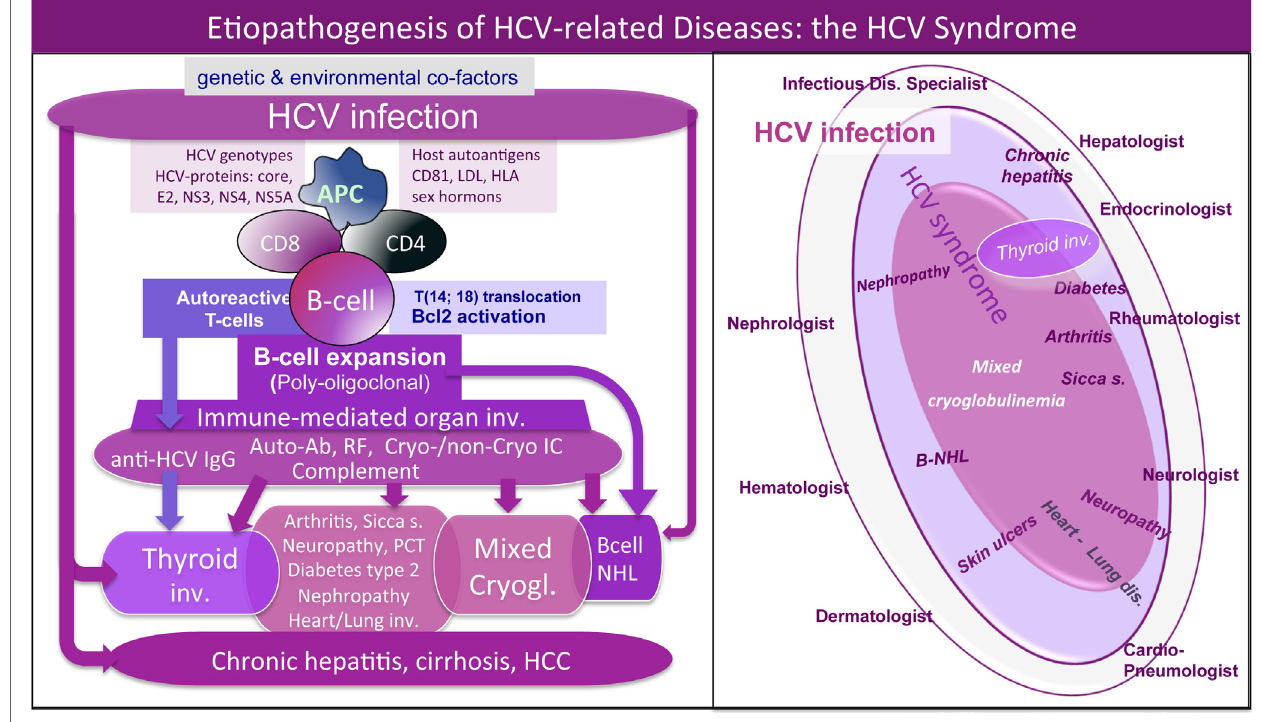
FigURe 1 | Etiopathogenesis of hepatitis C virus (HCV)-related disorders and HCV syndrome. Left : the etiopathogenesis of HCV syndrome includes both hepatic and extrahepatic disorders. They may develop through a multifactorial and multistep process that includes chronic HCV infection, other potential environmental/toxic triggers, genetically driven host predisposition (particularly HLA alleles, metabolic, and/or hormonal factors), and complex cellular and molecular alterations. From one side, we can observe HCV-driven immune-system alterations with prominent “benign” lymphoproliferation and autoantibody production, from the other side, deeper oncogenetic alterations leading to frank B-cell neoplasias and other malignancies (B-NHL, HCC, and papillary thyroid cancer). These different pathogenetic mechanisms are not mutually exclusive; during long-term follow-up, we can assist in the same HCV-infected patient to the appearance of different organ- and non-organ-specific autoimmune/neoplastic diseases, among which thyroid involvement. HCV antigens (core, envelope E2, NS3, NS4, NS5A proteins) may exert a chronic stimulus on the host immune system. Important pathogenetic steps include high-affinity binding between HCV-E2 and CD81 and consequent t (14;18) translocation with bcl-2 proto-oncogene activation, cross-reaction between particular HCV antigens and host autoantigens (molecular mimicry mechanism), and direct cell infection by HCV responsible for neoplastic cell transformation. The “benign,” often subclinical, B-cell proliferation with production of various autoantibodies, among which RF and cryo- and non-cryoprecipitable immune complexes may be frequently observed in chronically HCV-infected individuals. This condition may be the pathological substrate of various organ- and non-organ-specific autoimmune disorders, including thyroid involvement with/without mixed cryoglobulinemia (MC) syndrome or cryoglobulinemic vasculitis. Complicating malignancies can be observed in a small but significant percentage of patients, usually as a late complication of chronic HCV infection; moreover, both autoimmune and neoplastic disorders show a clinico-serological and pathological overlap. Right : schematic reproduction of the so-called “HCV syndrome” that encompasses the variety of HCV-related diseases. The majority of HCV-infected patients may remain totally asymptomatic or complicated by isolated liver involvement; however, a significant proportion of subjects may develop various extrahepatic manifestations that may include a variety of autoimmune/lymphoproliferative and neoplastic disorders; therefore HCV-positive patients are commonly referred to different specialists according the prevalent clinical manifestation(s). A number of HCV- infected patients may be referred early to the rheumatologist because of mild clinical manifestations such as arthralgias/mialgias, sicca syndrome, and/or RF seropositivity. MC syndrome, also termed cryoglobulinemic vasculitis, represents the prototype of extrahepatic, immune-mediated systemic disorder characterized by multiple organ involvement. In this scenario, HCV-related thyroid involvement is one of the most frequent manifestations, isolated or in association with other extrahepatic disorders, mainly cryoglobulinemic vasculitis. RF, rheumatoid factor; NHL, non-Hodgkin’s lymphoma; HCC, hepatocellular carcinoma; PCT, porphyria cutanea